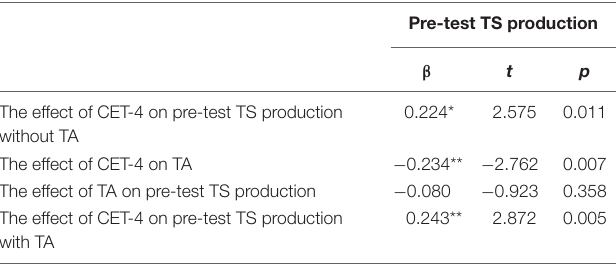
TABLE 5 | The partial mediating effect of TA between FLLP and the pre-test TS